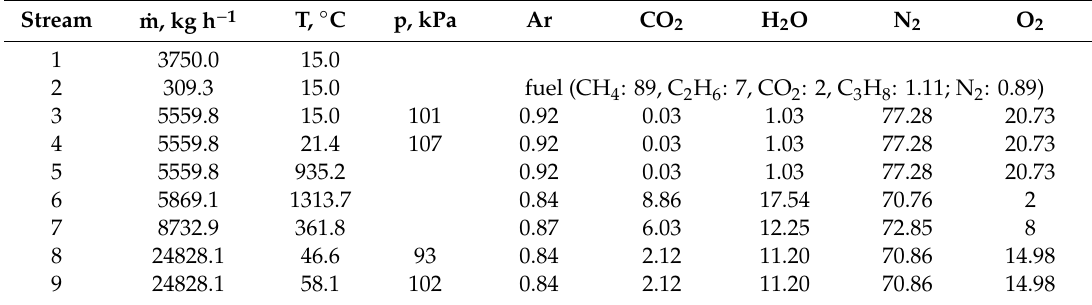
Table A1. Mass flow rates, temperatures, pressures and compositions (mol.%) at the main stations in Figure 11 for a glass melting furnace with production of 90 ton day − 1